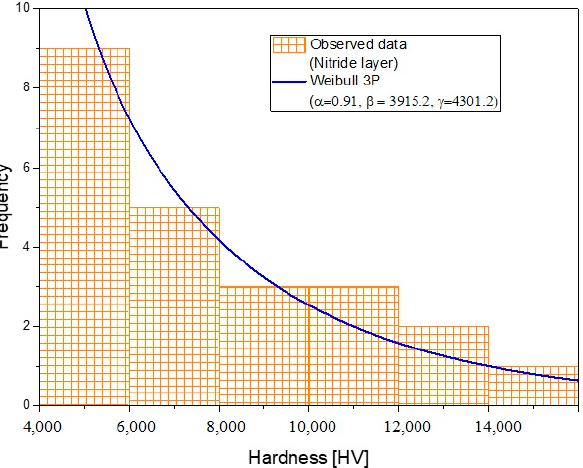
Figure 9. Nitride layer micro-hardness histogram fitted to Weibull 3P distribution.